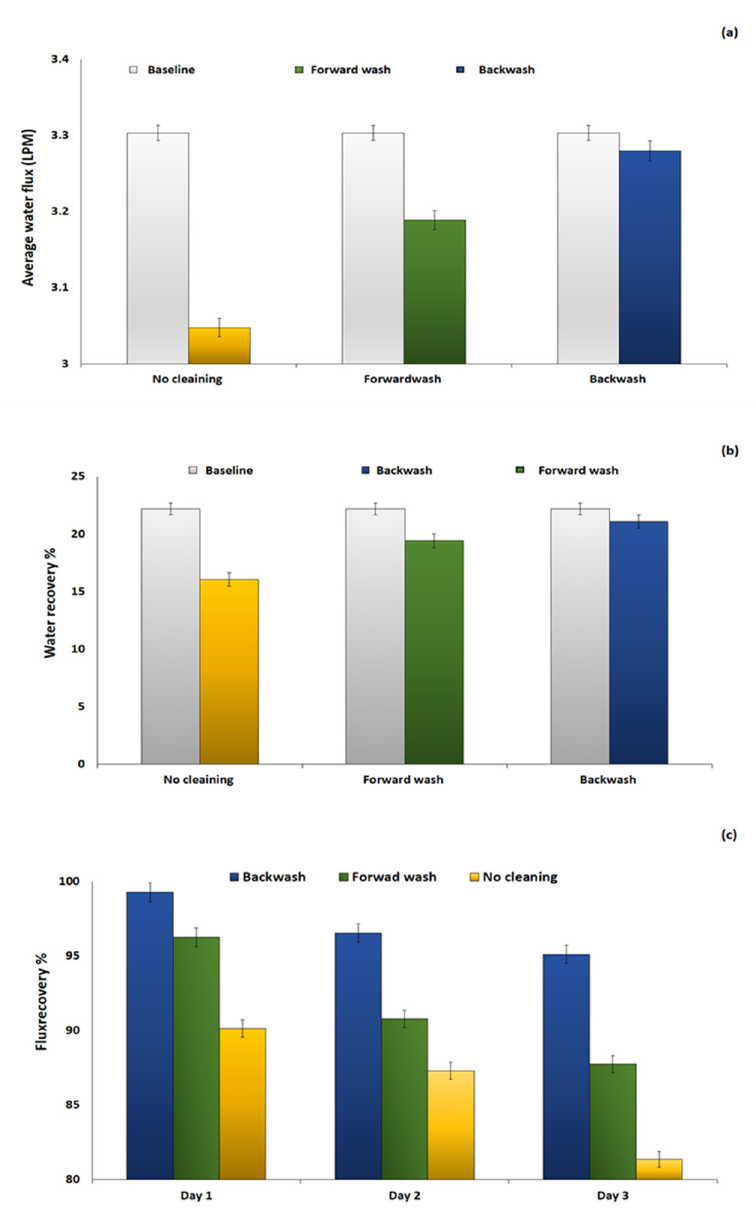
Figure 3. ( a ) Average water flux, ( b ) water recovery % and ( c ) flux recovery% after three